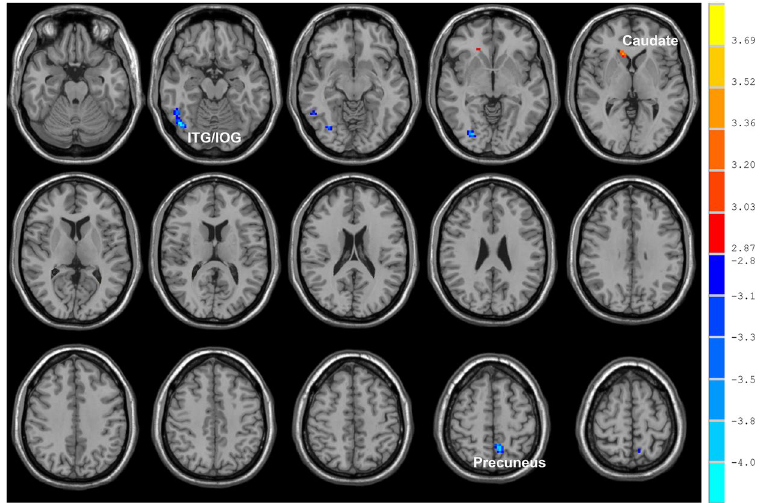
Figure 1. Brain areas of fALFF difference between smokers and nonsmokers. Areas in blue colors are brain regions where fALFF was significantly decreased in smokers compared with nonsmokers. The areas with decreased fALFF were the left precuneus, right ITG and IOG. Areas in red colors show significantly increased fALFF in smokers compared with nonsmokers. The area showing increased fALFF was the right caudate.